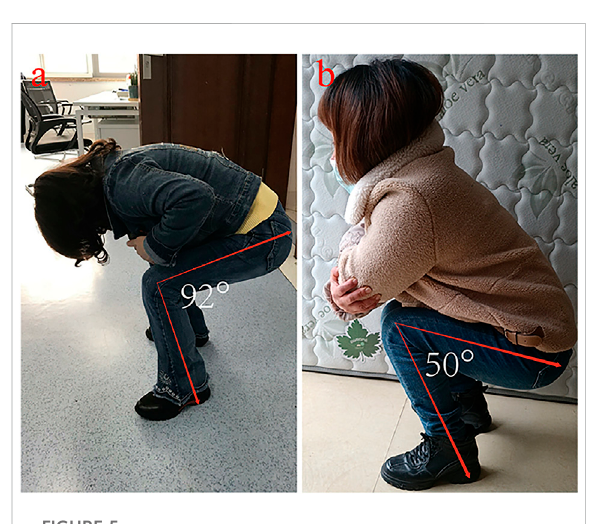
FIGURE 5 Knee fl exion is (A) 88 ° and (B) 130 ° 2 months and 27 months after surgery,